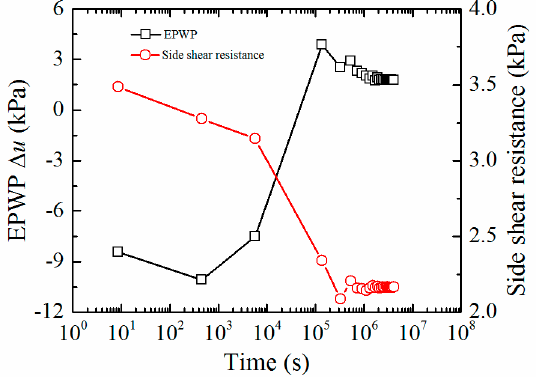
Figure 24. Comparison between the dissipation of EPWP and pile set-up at depth of 9.0 m after pile installation.